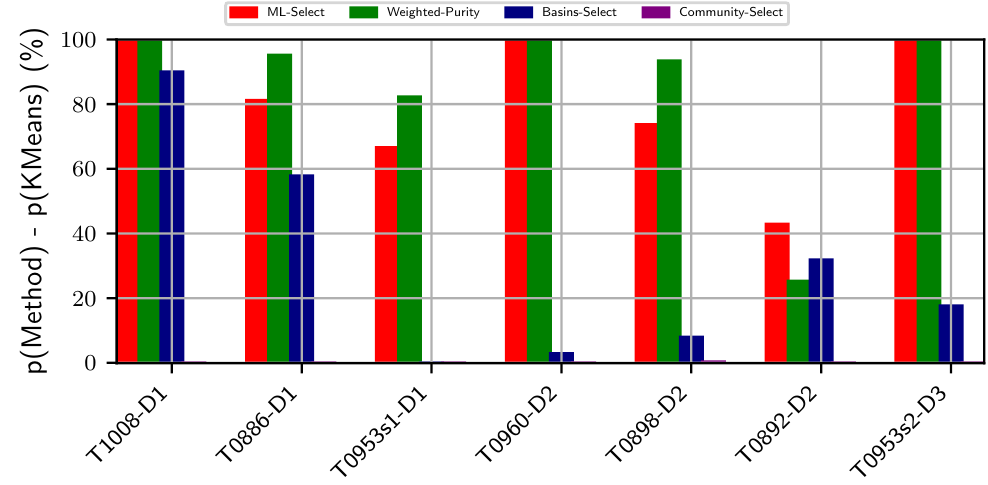
Figure 3. Visualization of two supervised and two unsupervised decoy selection strategies on the critical assessment of structure prediction targets. The y -axis tracks the difference in purity of the top basin predicted by each method with the purity of the top (largest) cluster obtained by KMeans-Select . The x -axis tracks the protein data bank entry id of each target protein. Color-coding is used to distinguish the different methods under